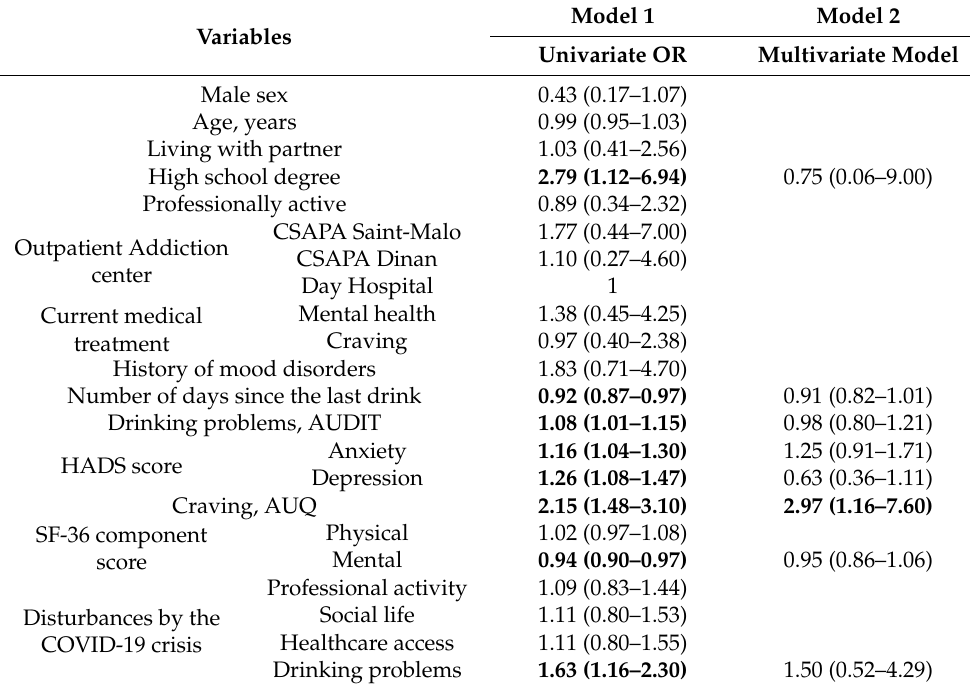
Table 3. Determinants of short-term alcohol drinking in patients with alcohol use disorder (N = 80) in the 28-day period after